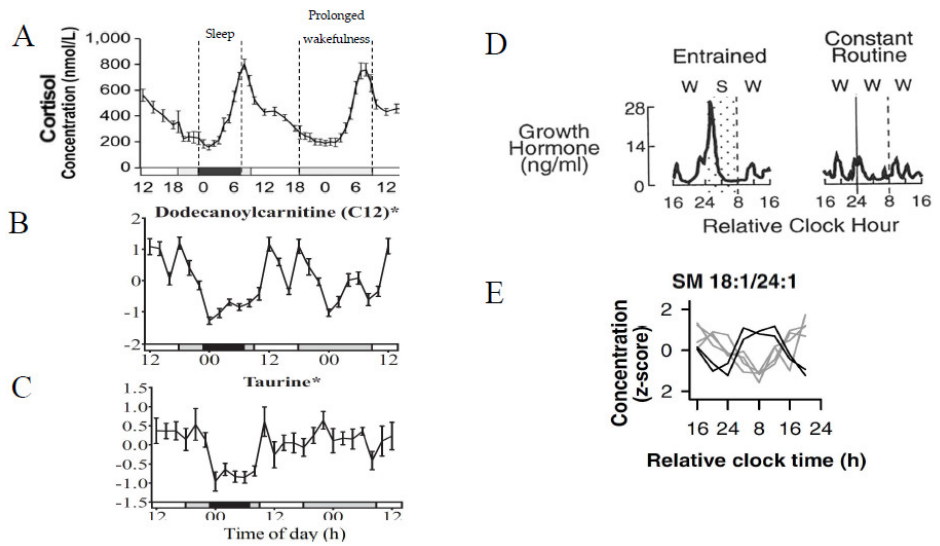
Figure 2. Comparative metabolite/hormone profiles under entrained conditions: sleep vs. prolonged wakefulness ( A – C ), entrained vs. circadian constant routine conditions ( D ), and inter-individual variation under constant routine conditions ( E ), reproduced from Honma et al. [50] ( A ), Davies et al. [51] ( B , C ), Czeisler & Klerman [52] ( D ), and Chua et al. [53] ( E ). A,B,C: Comparative profiles of cortisol, dodecanoylcarnitine (C12), and taurine under entrained light/dark conditions, sleep (highlighted in black) vs. prolonged wakefulness (highlighted in grey), with meals provided at 07:00 h, 13:00 h, 19:00 h, and 22:00 h (snack). No significant difference observed in cortisol, a SCN-driven hormone, between sleep conditions ( A ), peaks in measured intensity (y-axis) corresponding to mealtimes observable in various lipids and amino acids ( B , C ), alongside statistically significant perturbations during prolonged wakefulness vs. sleep [51]. D : Growth hormone rhythm observable under entrained conditions (peak during sleep) but dampened under constant routine. E: Individual rhythmic profiles of six participants showing inter-individual variation in lipid profiles (SM18:1/24:1), with two individuals displaying an inversed rhythm (~12 h ahead/delayed) relative to the other four